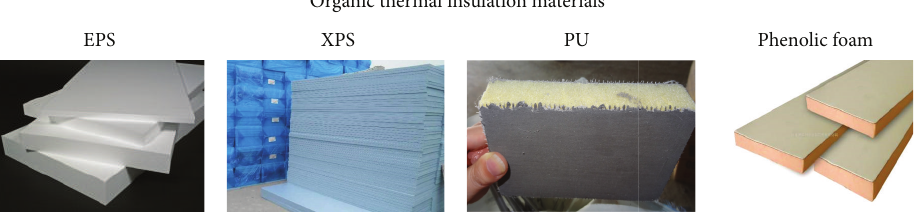
Figure 10: Classification of commonly used thermal insulation materials for buildings and their advantages and disadvantages.